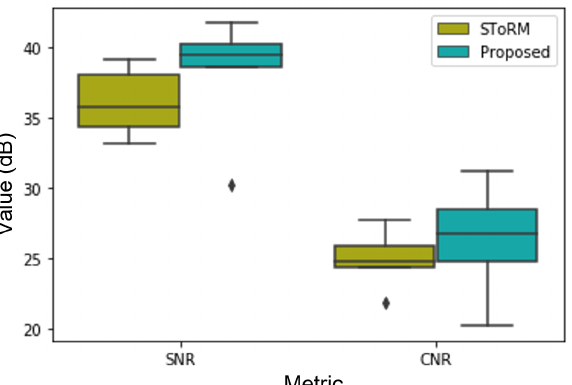
Figure 8. SNR and CNR comparison of the images reconstructed from the proposed scheme and the SToRM method. The average SNR and CNR of the images reconstructed from the proposed method are 37.99 dB and 26.28 dB. While the average SNR and CNR of the images reconstructed from SToRM are 36.01 dB and 24.89 dB. From the quantitative comparison, we can see that the proposed deep kernel method can provide improved image quality compared to the existing kernel